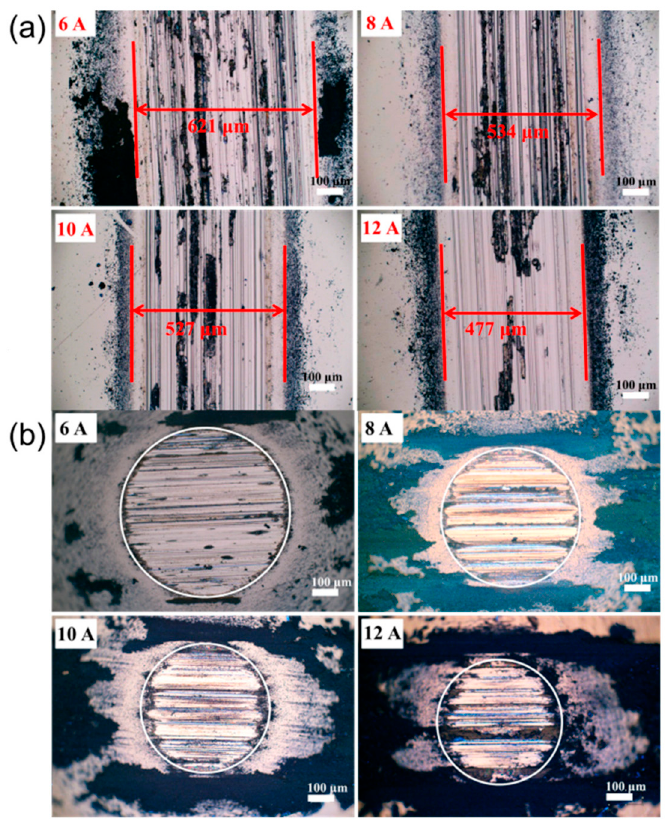
Figure 7. Optical images of ( a ) worn tracks and ( b ) worn morphologies of rubbing pair of the multilayer films deposited with various sputtering currents.